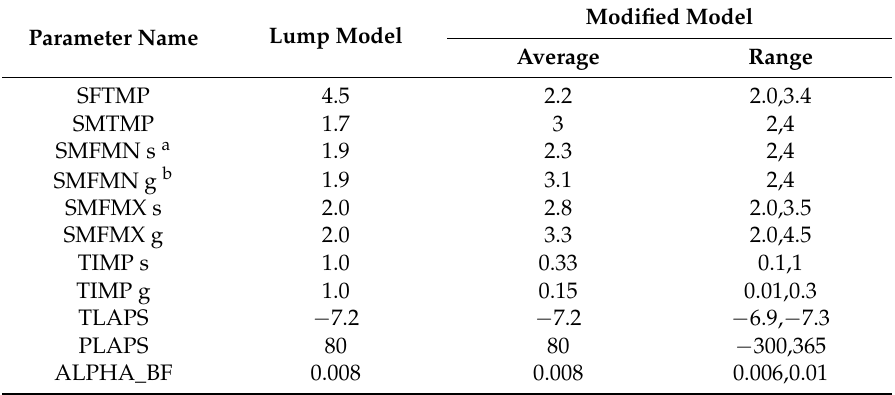
Table 6. Range and mean values of calibration parameters in subbasin-elevation band scale, Mendoza River Basin.